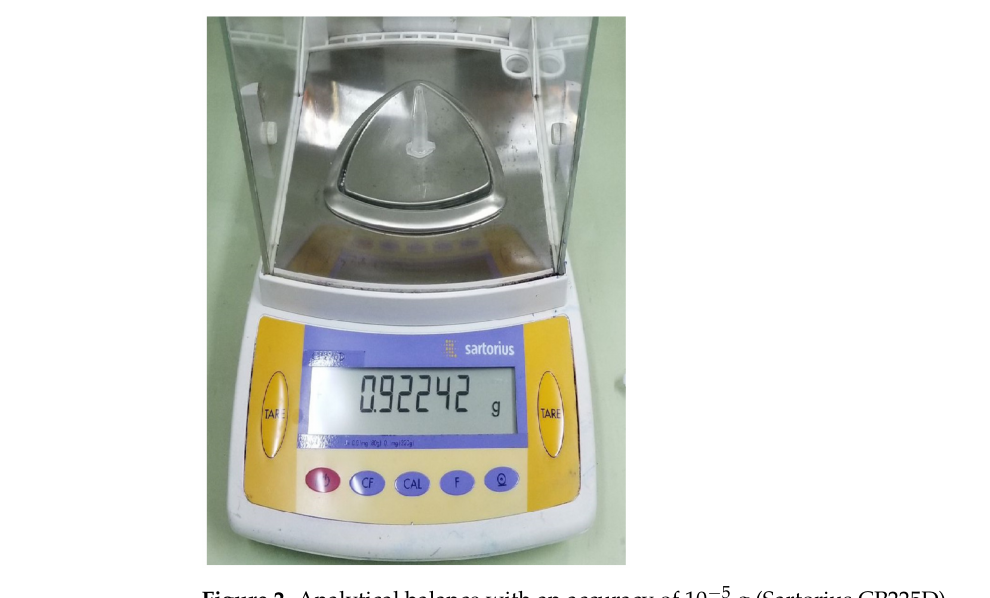
Figure 2. Analytical balance with an accuracy of 10 − 5 g (Sartorius